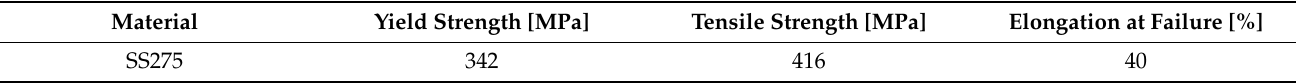
Table 3. Material properties of the SS275 steel.